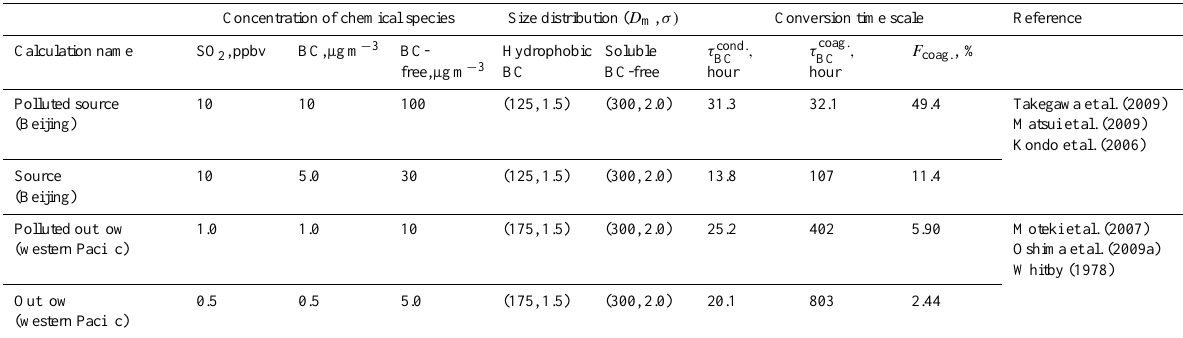
Table A2. Summary of the calculations for estimates of errors included in Eq. (9) due to neglect of coagulation effects on BC aging over the source and the outflow regions.